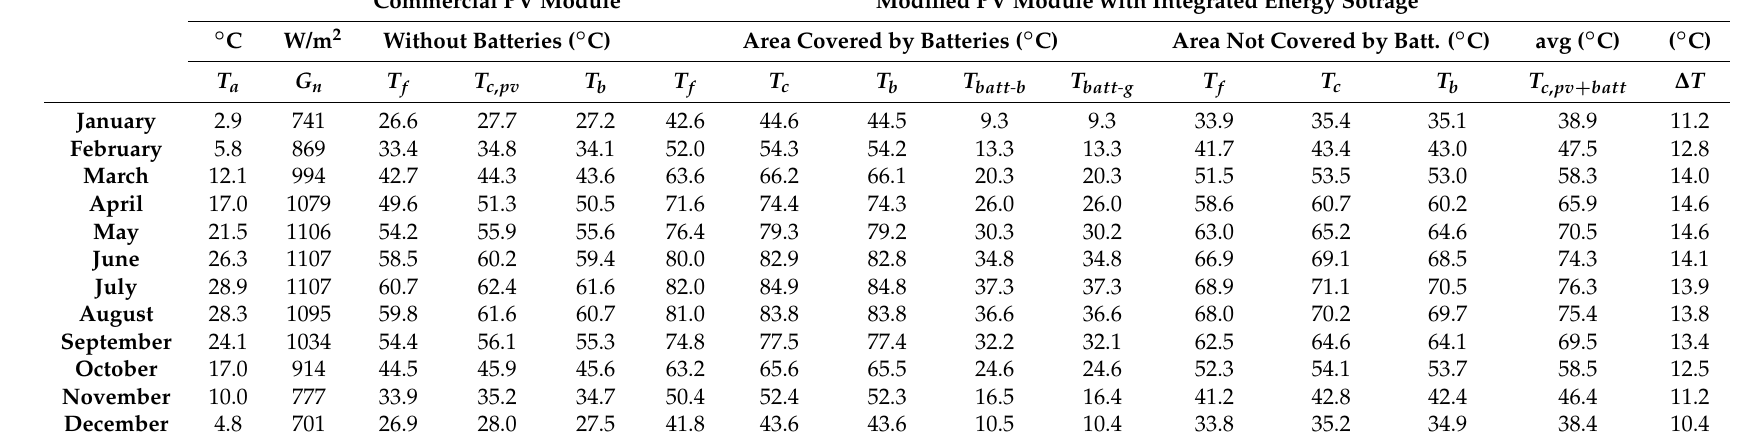
Table 3. Environmental data and temperatures obtained by thermal models (open circuit, P pv = 0).